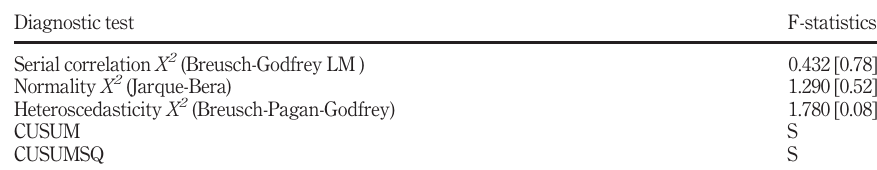
Diagnostic test